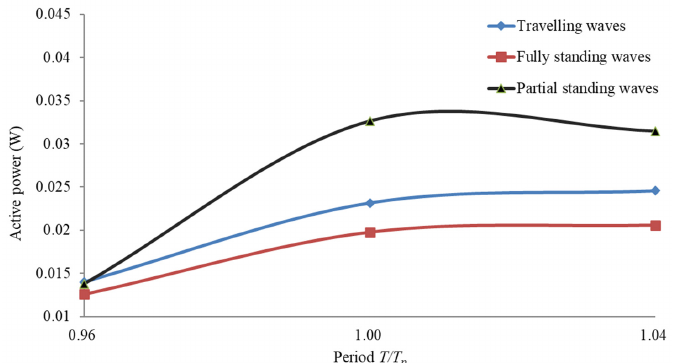
Figure 23. Comparison of generation performance under three different wave types at h = 0.6 m.